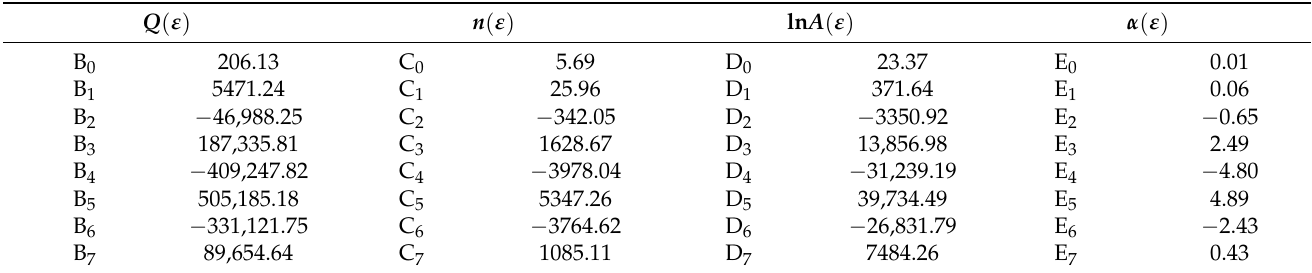
Figure 8. Relationships between: ( a ) Q ( ε ) ; ( b ) n ( ε ) ; ( c ) ln A ( ε ) ; ( d ) α ( ε ) and true strain by polynomial fitted of SAE 5137H steel. Table 2. Polynomial fitting results of Q ( ε ) , n ( ε ) , A ( ε ) and α ( ε ) of SAE 5137H